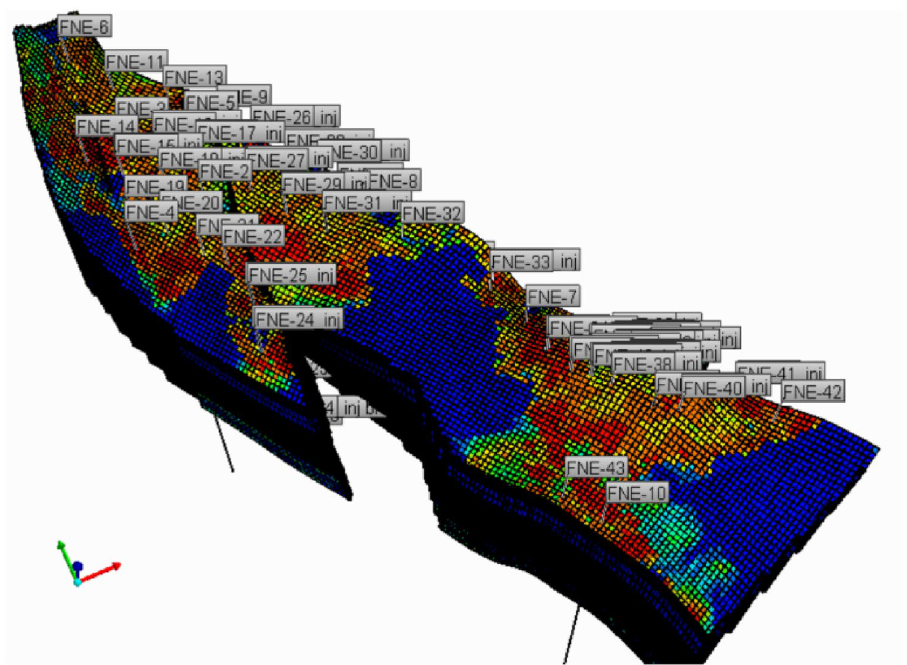
Fig. 4 3D view of porosity distribution and wells location in FNE oil